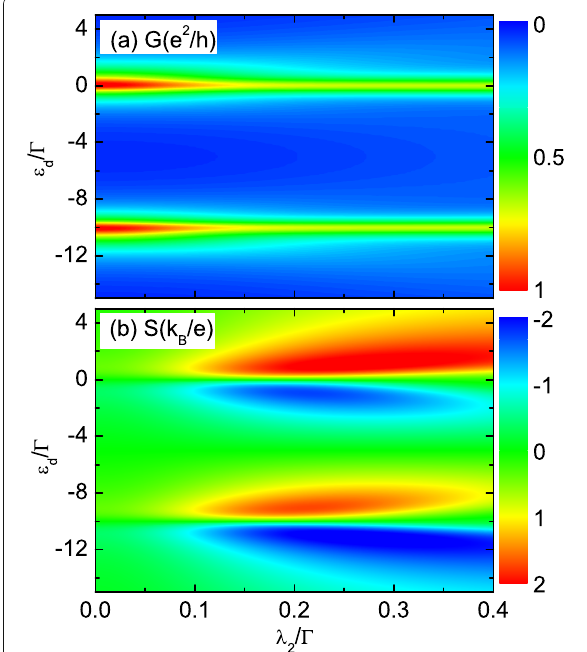
Fig. 5 Impacts of the other dot-Majorana coupling on the thermopower (color online). Impacts of λ 2 on the total conductance ( a ) and thermopower ( b ) with λ 1 = 0.2 (cid:6) , δ M = 0. Other parameters are the same as those of Fig. 2